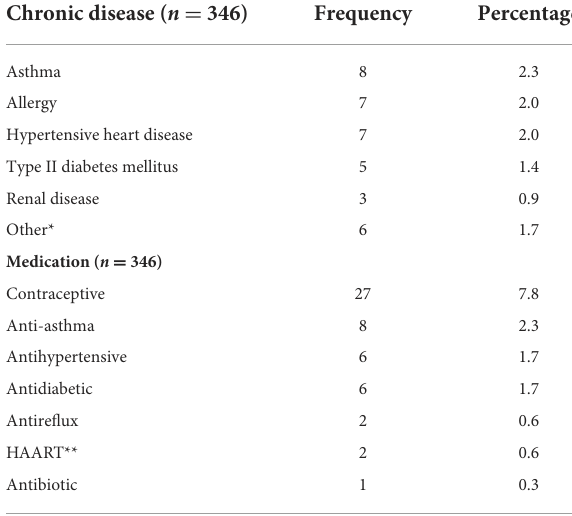
TABLE 2 Chronic diseases and medications taken by the respondents of COVID-19 vaccine side effects, Ethiopia,